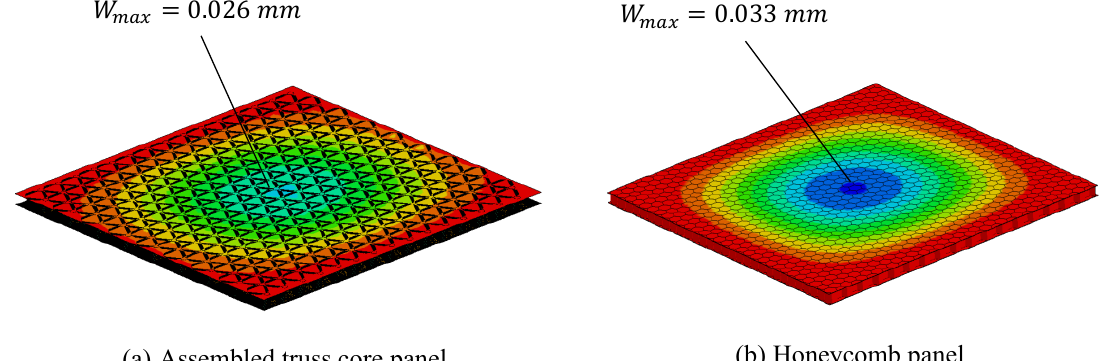
Figure 16. Analysis results of two types of lightweight panels under the same conditions. Table 4. Comparison of analysis results for assembled truss and honeycomb core panel.